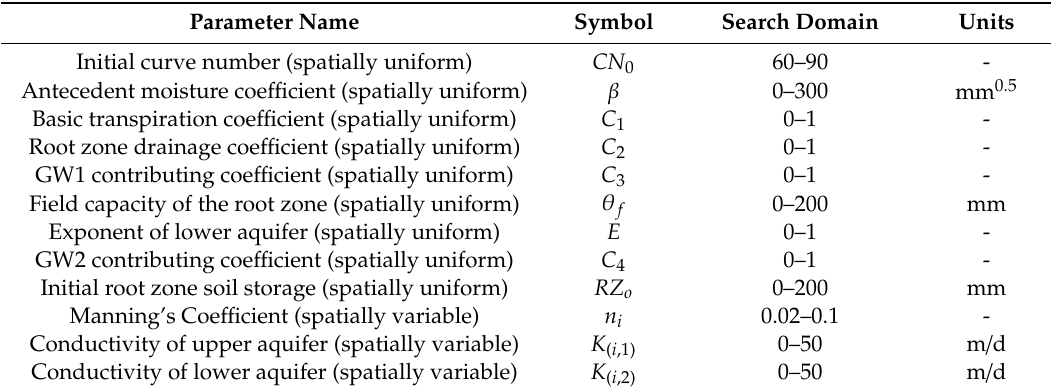
Table 1. Model parameters and their calibration